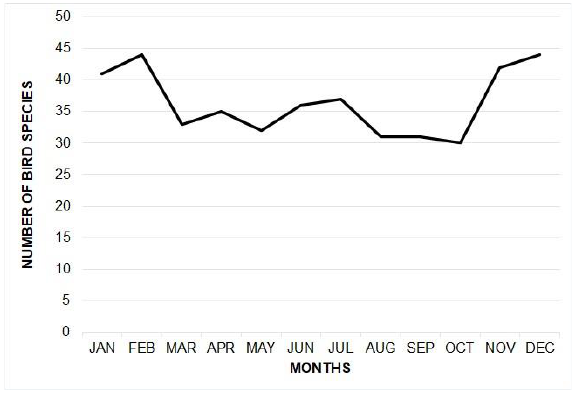
Figure 3. Variation in bird species number during the